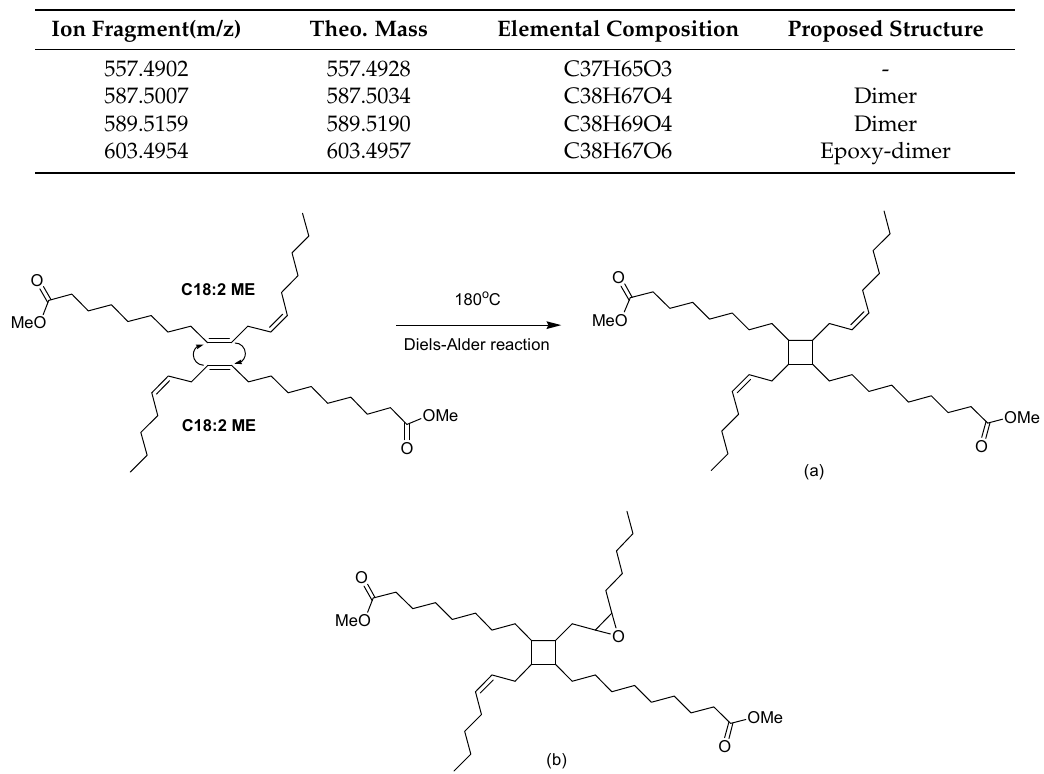
Table 3. Identification by HPLC-APCI MS detection of FAME polymer from C18:2 ME.